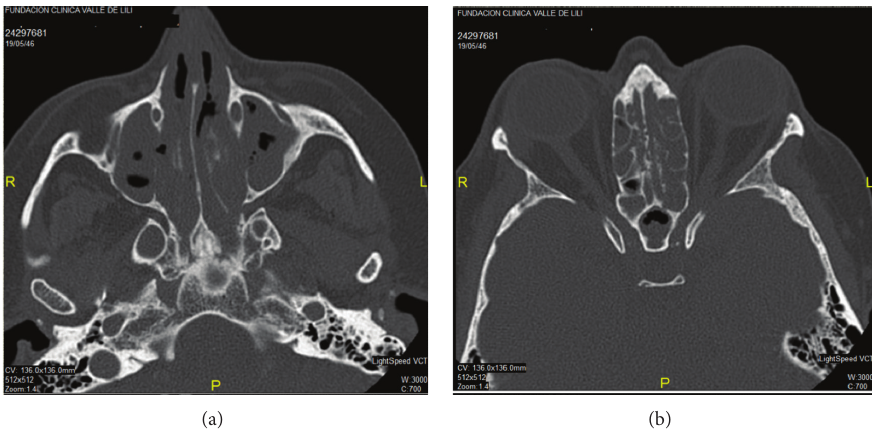
Figure 3: CT showing a diffuse sinus disease without erosions in a patient with granulomatosis with